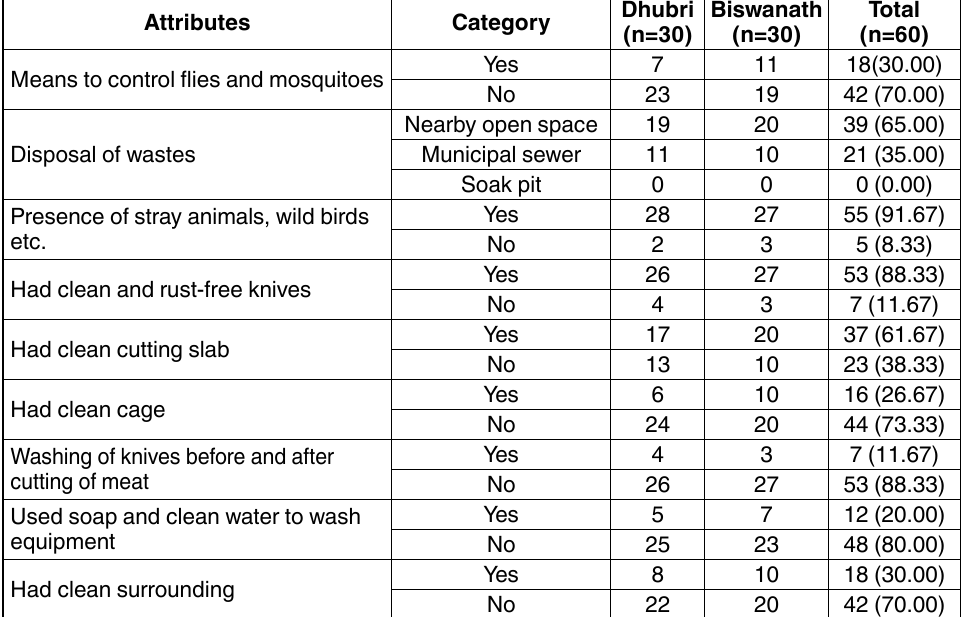
Washing of knives before and after cutting of meat Used soap and clean water to wash equipment Had clean surrounding table 5. Distribution of respondents based on the slaughtering practices Attributes category Slaughter method Ensured complete drainage of blood from the carcass Blood was collected to prevent environmental pollution Blood was spread over the carcass Washed carcass before and after evisceration Removed viscera immediately after killing the bird the respondents. Majority (90%) of the poultry the study areas (Table 3). Majority (88.33%) of meat shops had adequate lighting facility the respondents did not wear protective clothes (Table 2). Displaying carcasses under open sky (face mask, head gear, hand gloves and aprons), and only a few (11.67%) of them wore might expose to dust resulting in deterioration of meat quality. Most (76.67%) of the shops such protective clothes. Wearing clean clothes were equipped with waste bins to store wastes and other protective clothes could be the good before being permanently disposed off. practices at personal level to produce superior quality meat. The use of gloves by butchers is Only 18.33 per cent of the poultry butchers wore clean cloth while 81.67 per cent of did not wear clean cloth during their job in